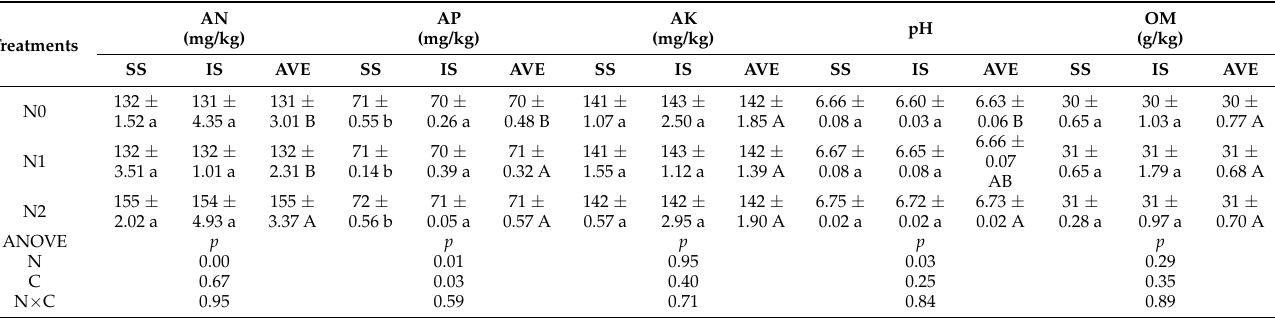
Table 2. Soybean soil physicochemical characteristics of different treatments with different nitrogen application rates.